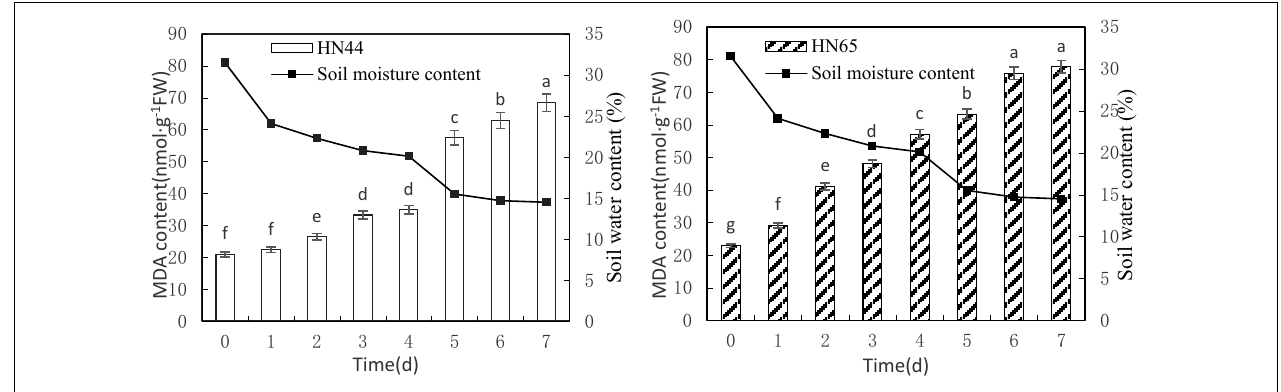
FIGURE 1 | Effect on MDA content under different soil water contents. Indicates that the values marked with different letters are significantly different, and those marked with the same letter are considered to be statistically insignificant.